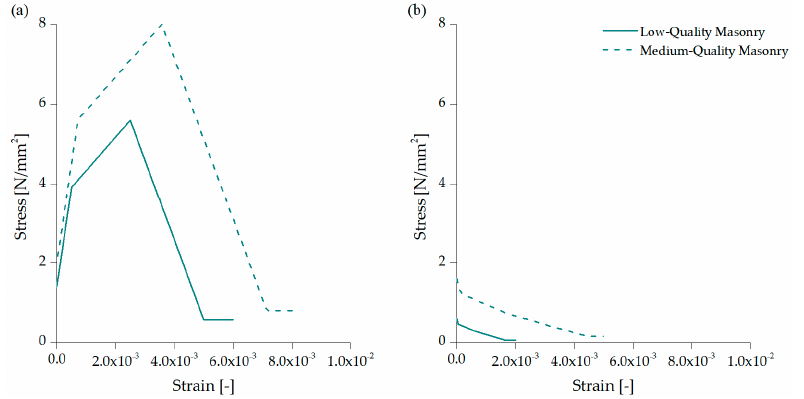
Figure 7. CDP constitutive laws defined in compression ( a ) and tension ( b ).